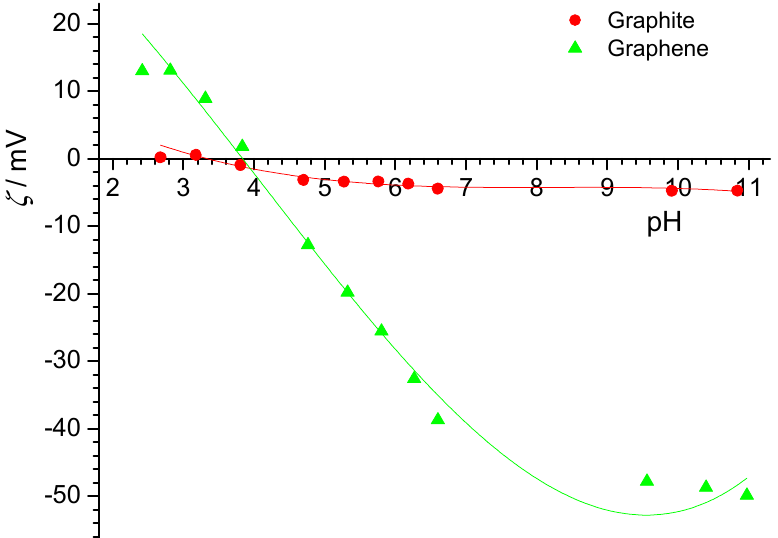
Figure 8. Electrokinetic potential of various inert flat surfaces in aqueous NaCl solution. Lines represent third order polynomial fit used to determine pH iep . I c = 2 mmol dm − 3 , θ = 25 °C.